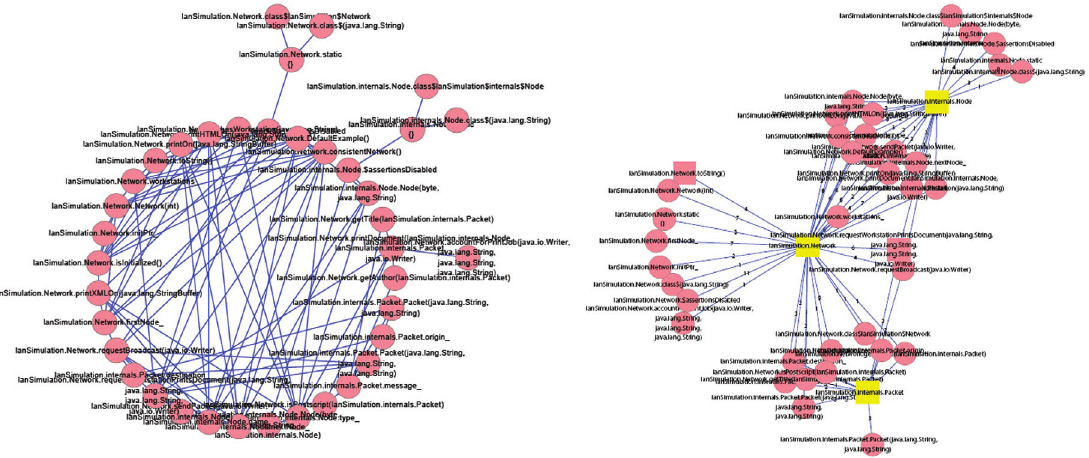
Figure 5. uFDN (Left) and CFSON (Right) for LAN-Simulation.